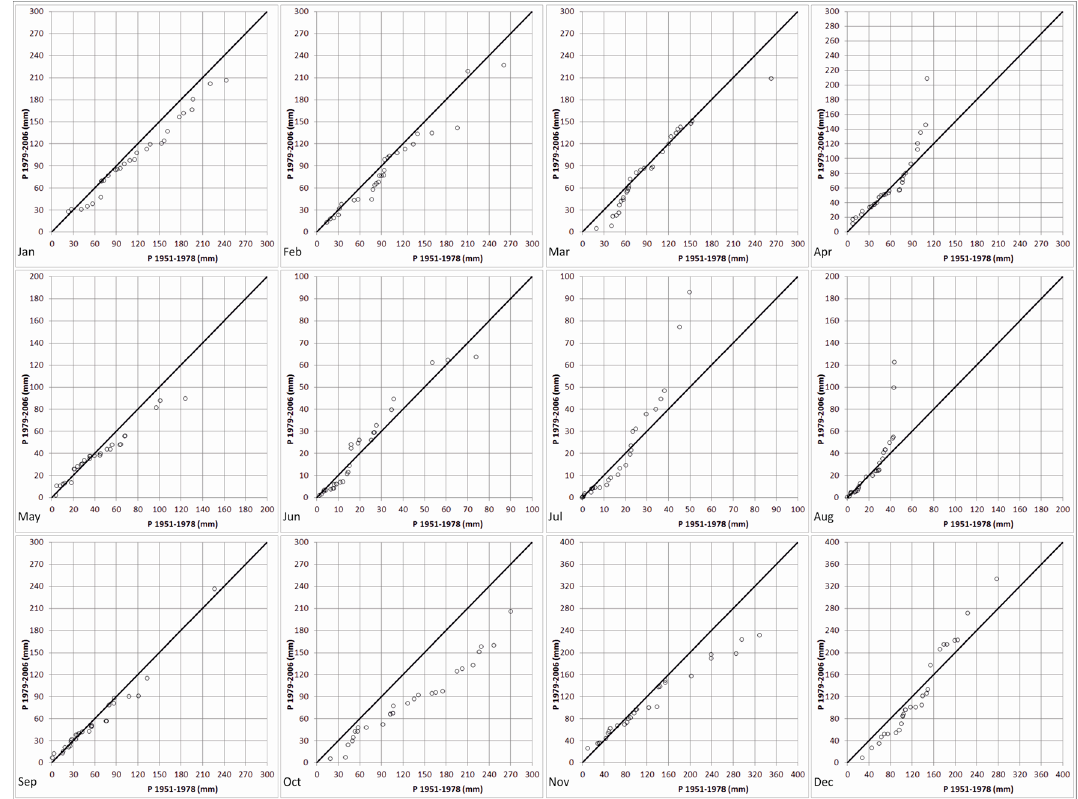
Figure 2. Results of the ITA method for the Rainfall Zone I1 for the period